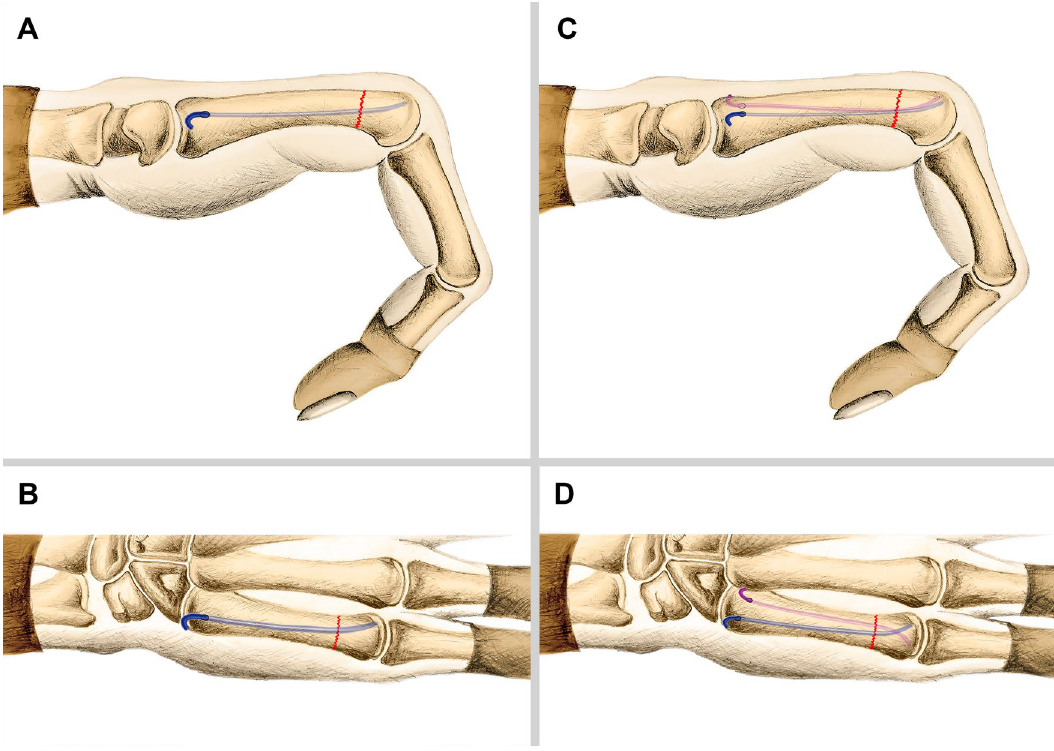
Figure 1. Schematic illustration of an FMNF fixed with single AEIMN on lateral view ( A ) and anteroposterior view ( B ), and fixed with dual AEIMNs on lateral view ( C ) and anteroposterior view ( D